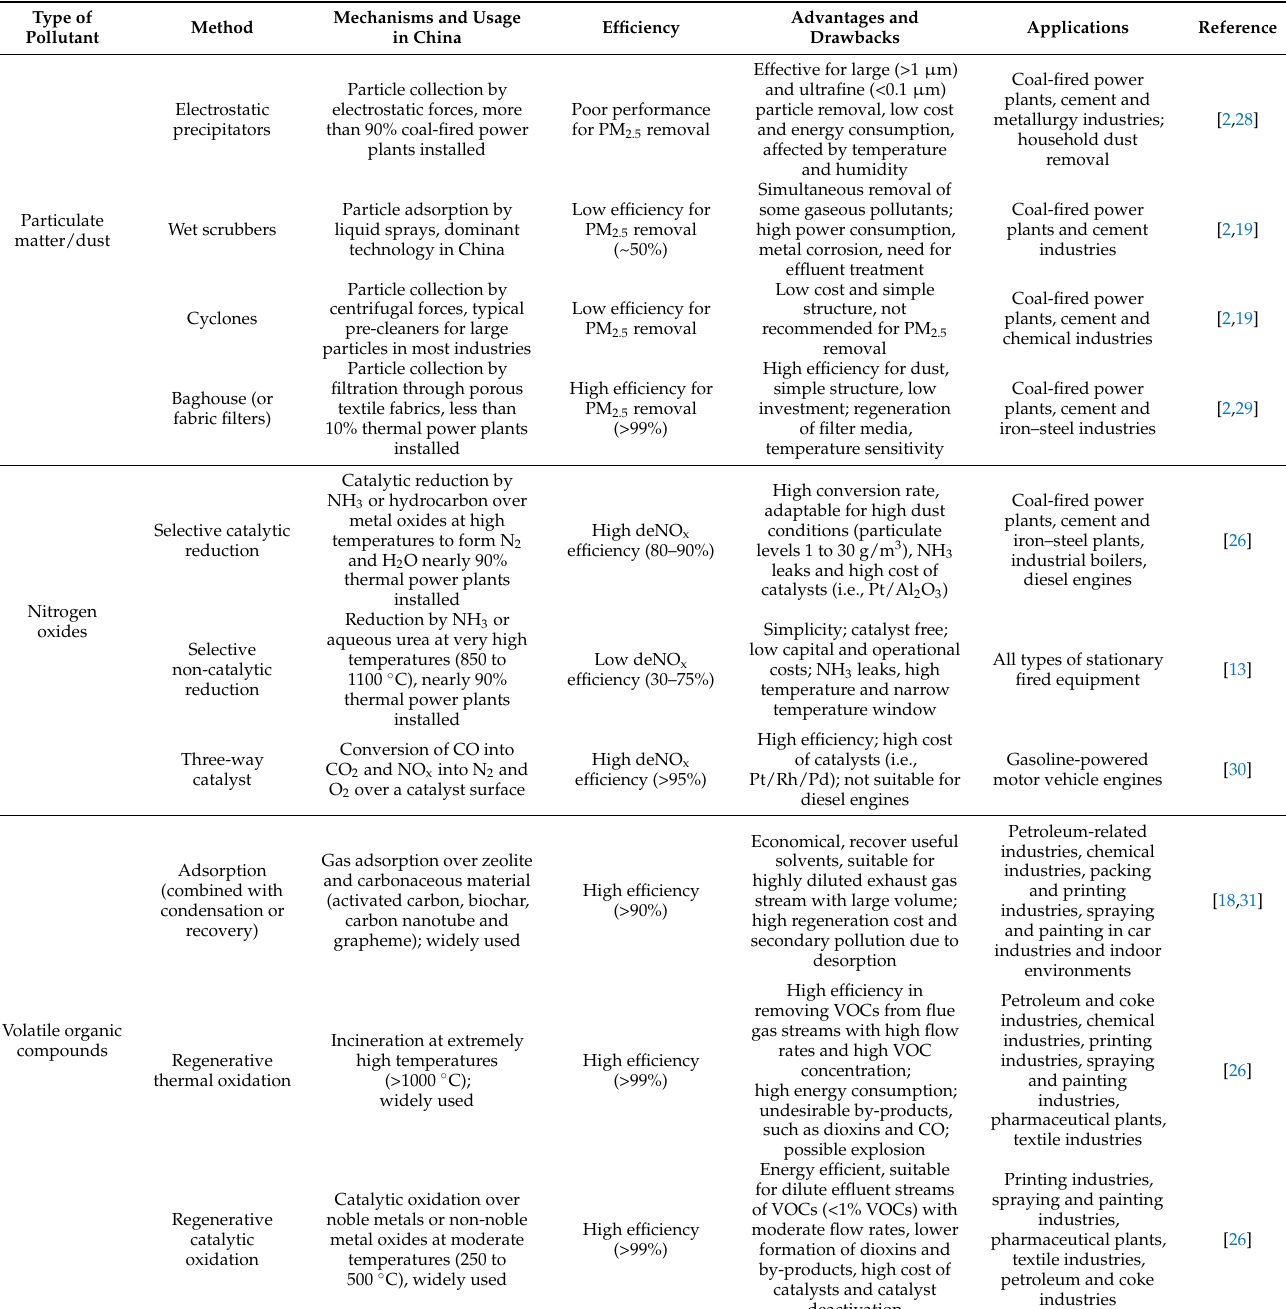
Table 1. Major post-combustion control methods for particulate matter, NO x and VOCs mitigation from